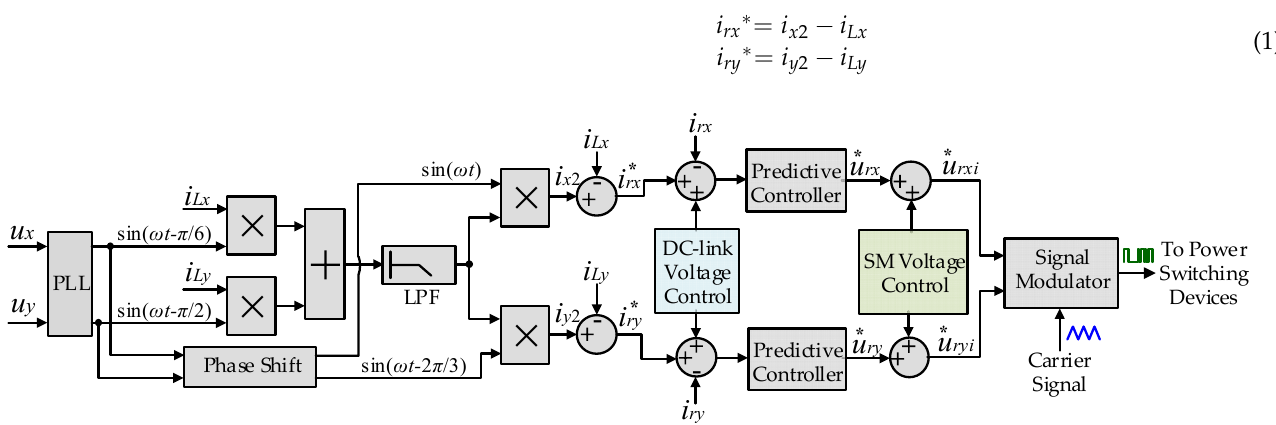
Figure 4. RPC based on half-bridge MMC and V/V power transformer control